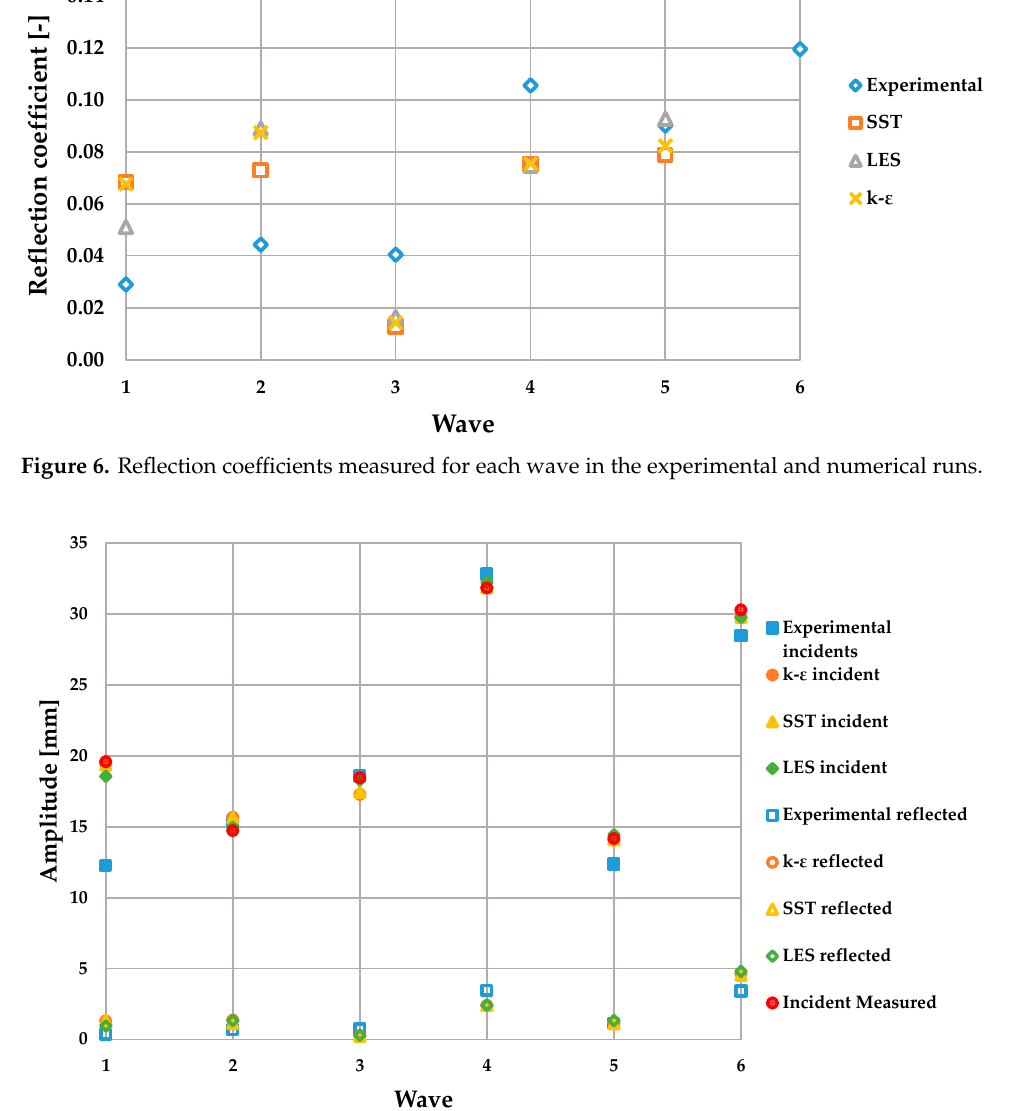
Figure 7. Comparison of the incident and reflected amplitudes of the waves by the reflection method developed by Mansard and Funke for the experimental and numerical runs.